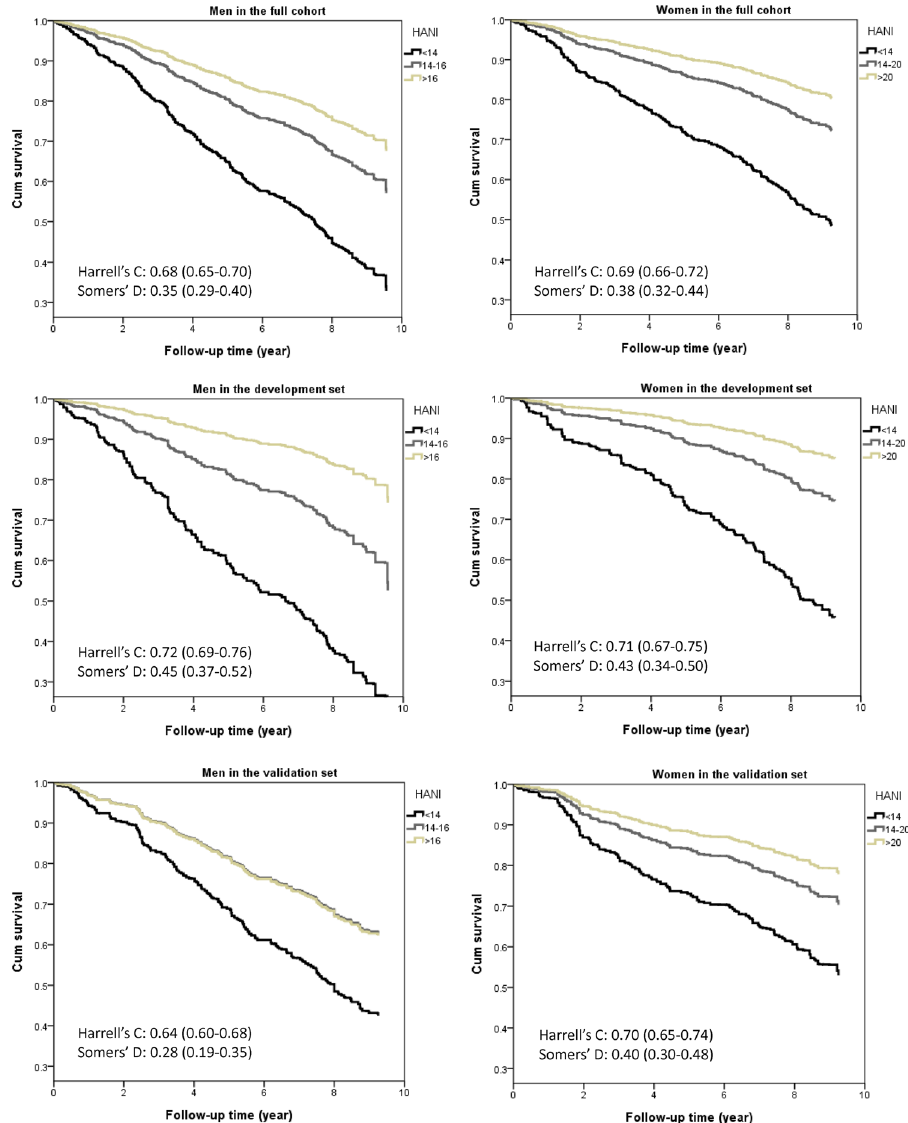
Figure 3. Cumulative survival curves for all-cause mortality by HANI, adjusted for region, education level, smoking status, physical activity, social engagement, and cognitive impairment. HANI, Healthy Ageing Nutrition